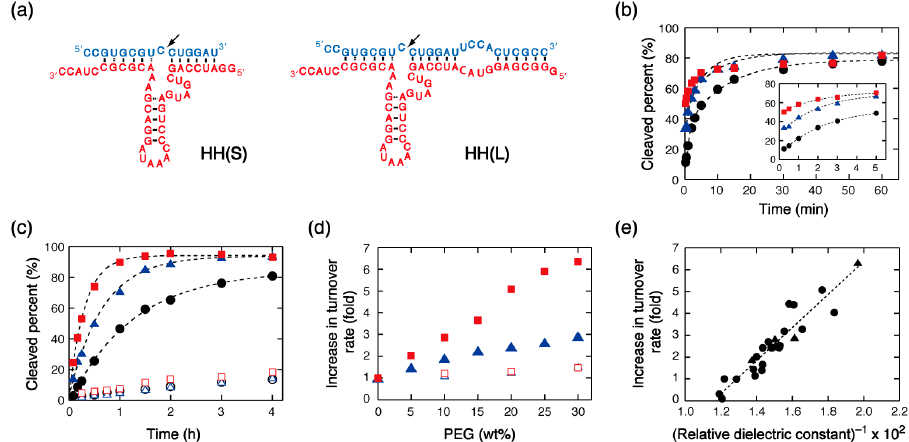
Figure 1. ( a ) Structures of the hammerhead ribozymes and their substrates used in this study. The cleavage sites are indicated by arrowheads. ( b ) Kinetic traces for substrate cleavage catalyzed by HH(L) under single ‐ turnover conditions in the presence of 10 mM MgCl 2 and in the absence (black circles) and presence of PEG8000 (red squares) or PEG200 (blue triangles). The data relative to the first 5 min of the reaction are enlarged in the inset. ( c ) Kinetic traces for substrate cleavage catalyzed by HH(S) (closed symbols) and HH(L) (open symbols) under multiple ‐ turnover conditions in the presence of 10 mM MgCl 2 and in the absence (black circles) and presence of PEG8000 (red squares) or PEG200 (blue triangles). ( d ) Increments of the turnover rate of the reactions catalyzed by HH(S) (closed symbols) or HH(L) (open symbols) in the presence of 10 mM MgCl 2 plotted against the amount of PEG8000 (red squares) or PEG200 (blue triangles) in solution. ( e ) Plot of the increments of the turnover rate of the HH(S) ‐ catalyzed reaction in the presence of 10 mM MgCl 2 against the inverse of the relative dielectric constant of solutions. The data obtained using 10% or 30% PEG solutions (PEG8000 and PEG200) are also included (triangles). The correlation coefficient of a linear fit is 0.94.